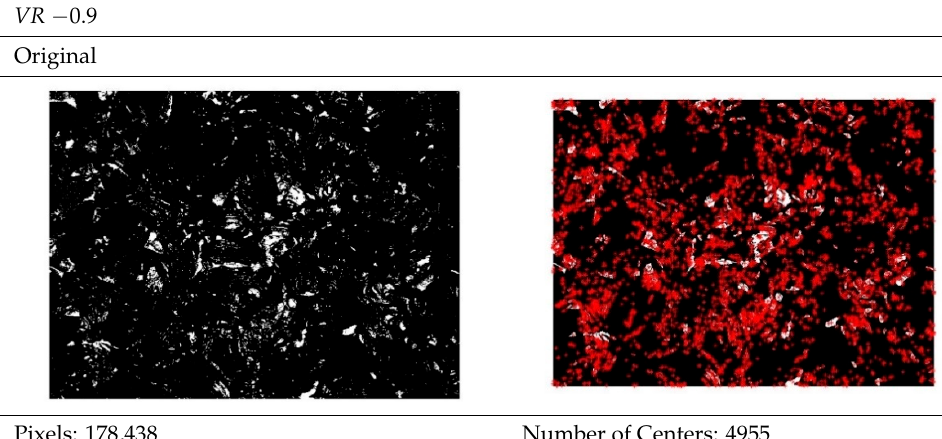
Table A8. Images and associated pixels and number of centers corresponding to VR = − 0.9. Table A8 . Images and associated pixels and number of centers corresponding to VR = − 0.9. Table A8 . Images and associated pixels and number of centers corresponding to VR = − 0.9. Table A8 . Images and associated pixels and number of centers corresponding to VR = − 0.9. Table A8 . Images and associated pixels and number of centers corresponding to VR = − 0.9. Table A8 . Images and associated pixels and number of centers corresponding to VR = − 0.9. Table A8 . Images and associated pixels and number of centers corresponding to VR = − 0.9. VR − 0.9 VR − 0.9 VR − 0.9 VR − 0.9 VR − 0.9 VR − VR − 0.9